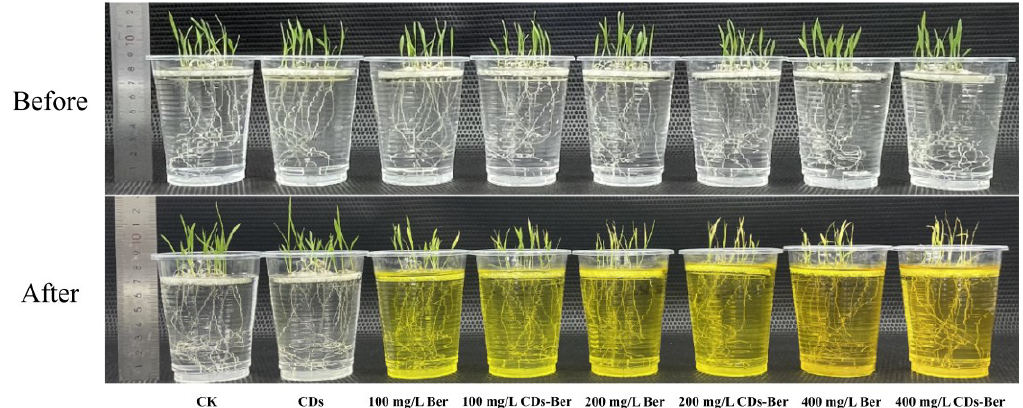
Figure 6. Hydroponic treatment of Echinochloa crus-galli with CDs, berberine, and CDs-Ber; The first line is before processing, and the second line is after processing (concentrations of berberine and CDs-Ber are 100, 200, and 400 mg/L; CK is deionized water).